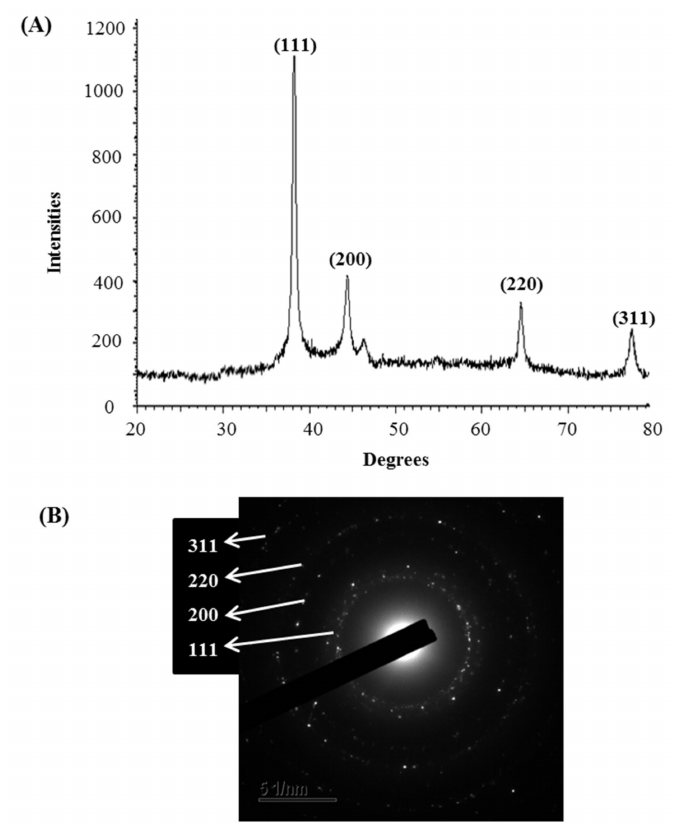
Figure 4. X-ray diffraction pattern ( A ) and SAED pattern ( B ) of P. nicotinovorans MAHUQ-43- mediated synthesized